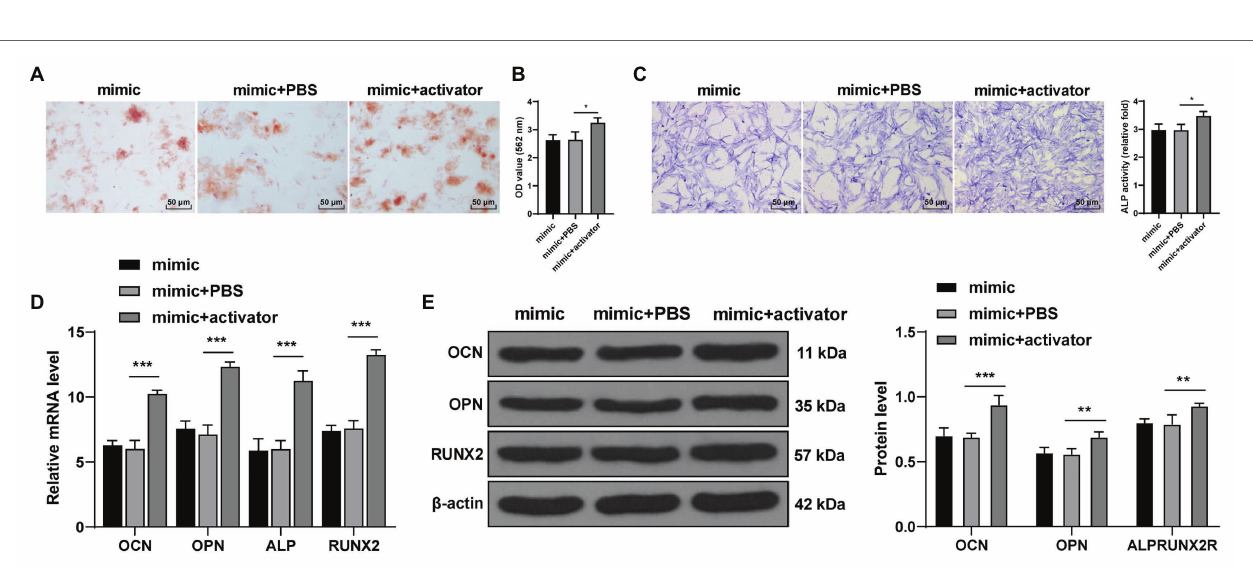
FIGURE 6 | Activation of the Wnt pathway reversed the inhibitory effect of miR-143-3p mimic on osteogenic differentiation of hPDLCs. (A,B) Osteogenic differentiation of hPDLCs was measured using ARS staining and ARS semi-quantitative analysis. (C) ALP activity was measured using ALP staining. (D,E) Levels of osteogenic specific markers (OCN, OPN, ALP, and Runx2) were detected using RT-qPCR and Western blotting. The experiment was repeated three times. Data are expressed as mean ± standard deviation. One-way ANOVA was applied to assess data in panels (B,C) , and two-way ANOVA was applied to assess data in panels (D,E) , followed by Dunnett’s multiple comparisons test or Tukey’s multiple comparisons test, * p < 0.05, ** p < 0.01, *** p <